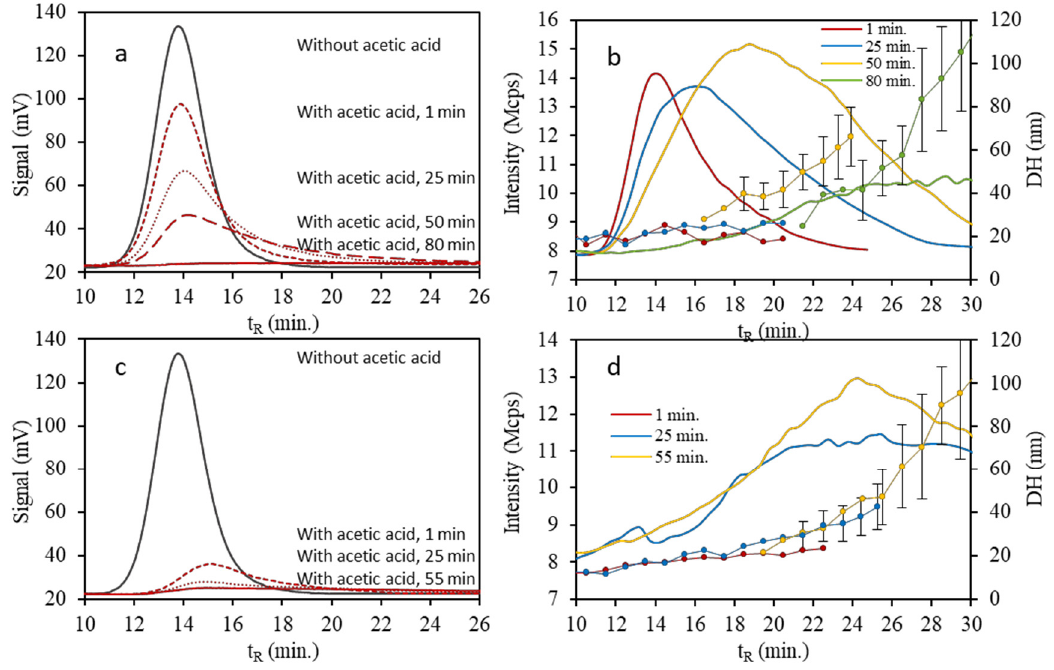
Figure 10. Fractograms wth UV-Vis detection corresponding to suspensions of AgNPs in a 1: 4 dilution (5 µ g / mL) and 1.5 mM ( a ) or 3 mM ( c ) acetic acid at di ff erent times. Fractograms with DLS detection and hydrodynamic diameter (DH) (confidence interval α = 0.05) corresponding to the same suspensions at di ff erent times ( b , d ) respectively.